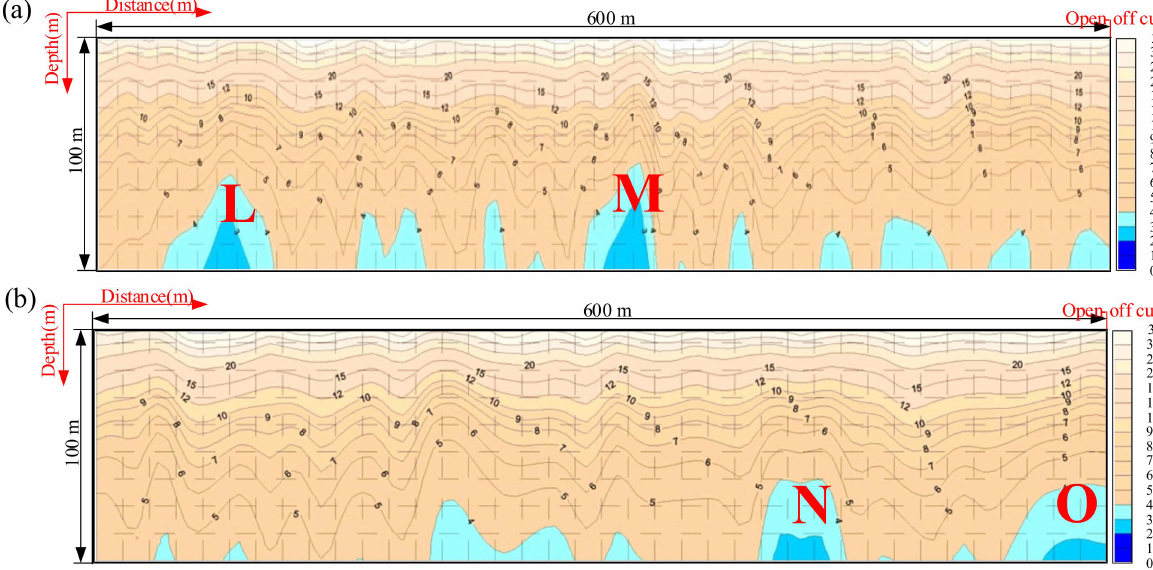
Figure 9. TEM results along the gate road of Working Face 2509 after grouting: ( a ) the upper gate road; ( b ) the lower gate